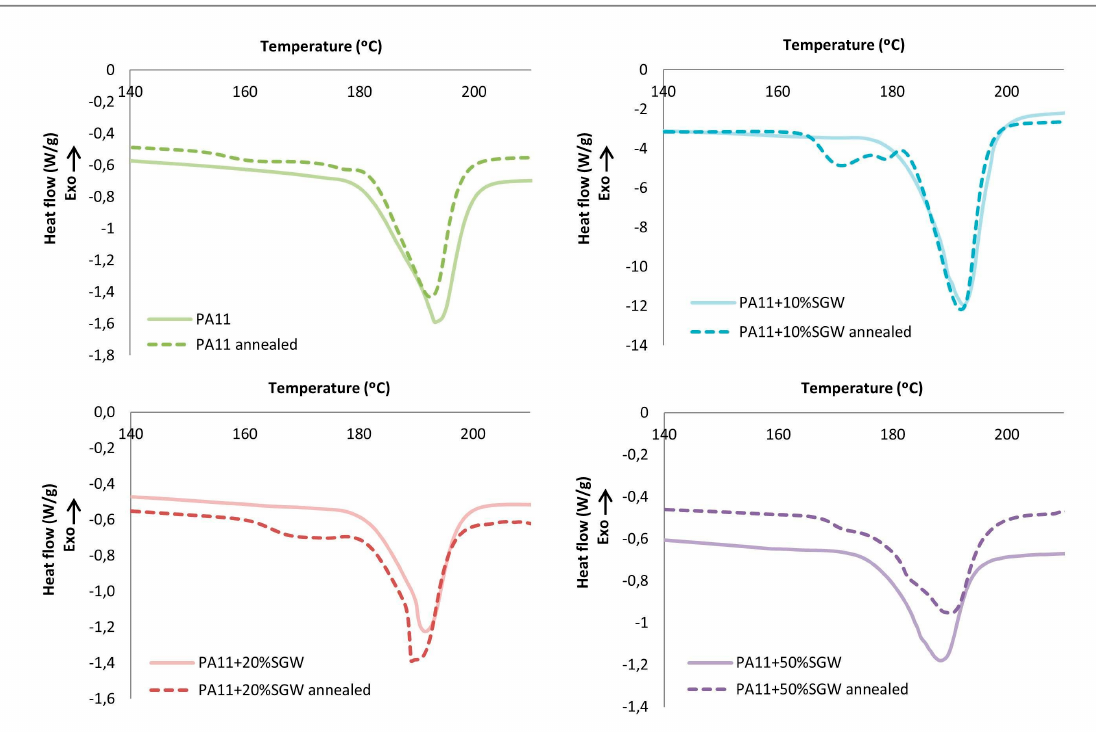
Figure 7. DSC thermographs of the firsts heating comparing annealed and not annealed samples.